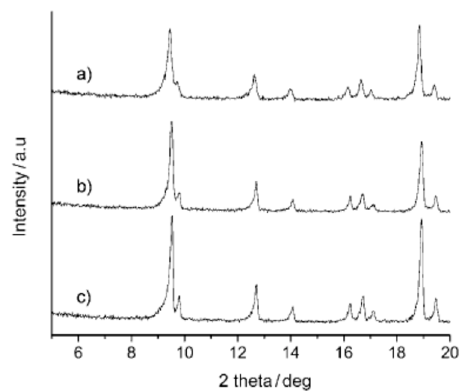
Figure 1. The XRD patterns of MIL-53 (Fe) synthesised at 70 °C by ( a ). US (35 min); ( b ). MW (2 h); and ( c ). CE (3 d). Reproduced with permission from [59].